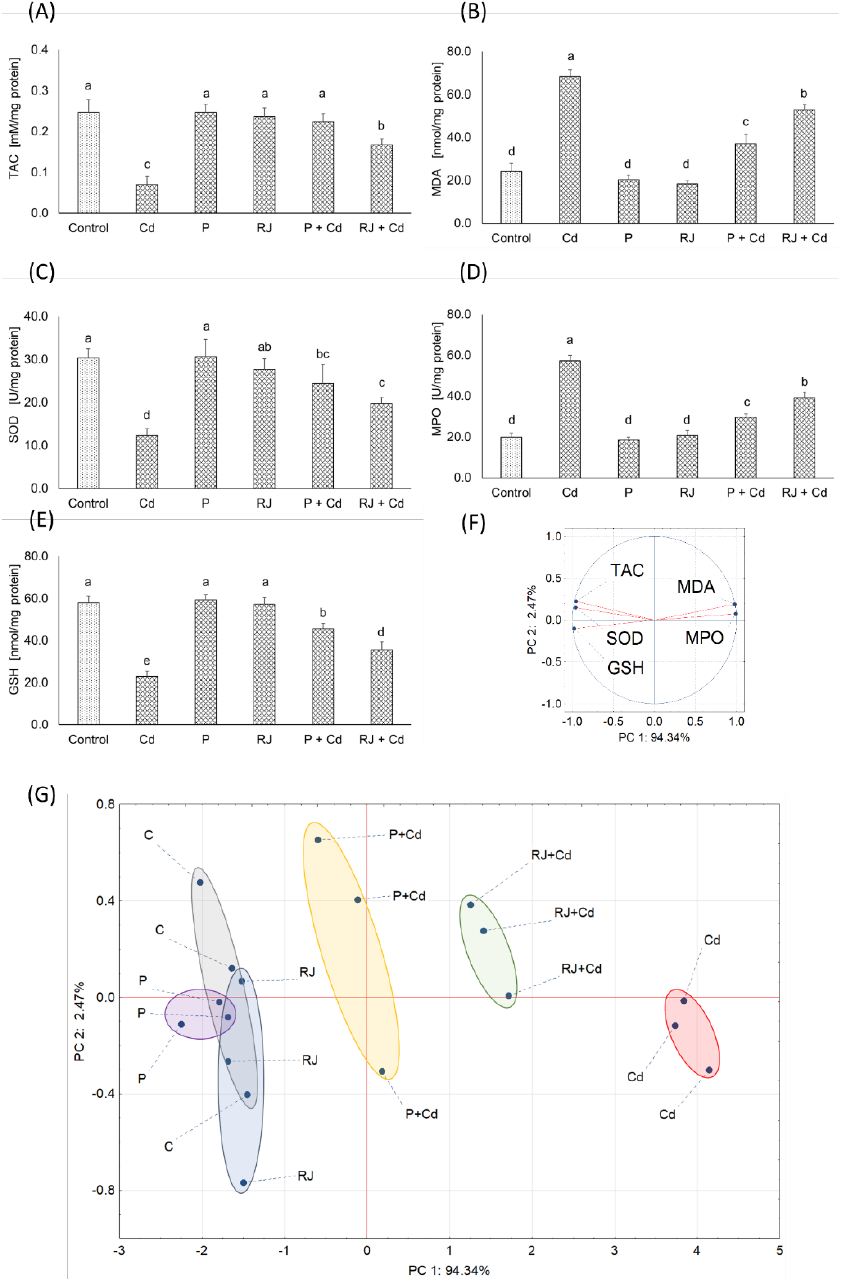
Figure 6. Oxidative stress markers in females’ ovaries. ( A ) total antioxidant capacity (TAC); ( B ) malondialdehyde concentration (MDA); ( C ) superoxide dismutase (SOD) and ( D ) myeloperoxidase (MPO) activity; ( E ) reduced glutathione (GSH) concentration. ( F ) Principal component analysis (PCA) on oxidative stress markers variables, and ( G ) 2D PCA plot of control and experimental group cases. The same letters in each chart, a–e denotes homogenous groups (ANOVA; HSD Tukey test; p < 0.05). Shape colors in ( G ) denote: gray—Control group, violet—Propolis group, blue—Royal Jelly group, yellow—Cadmium + Propolis group, green—Cadmium + Royal Jelly group, red—Cadmium group.